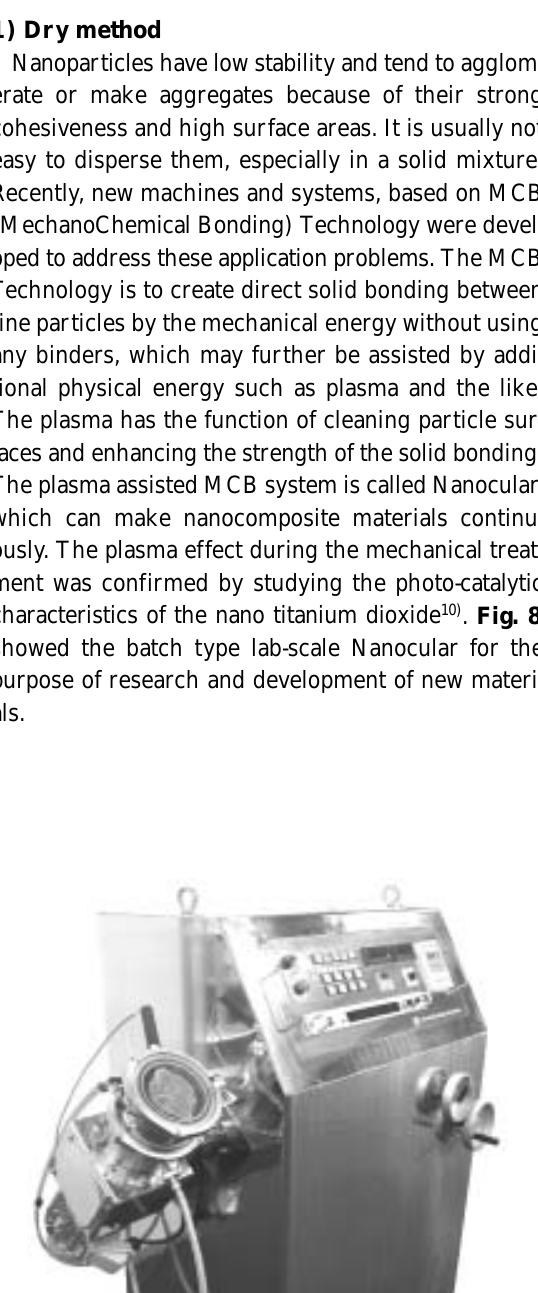
Energy consumption (cid:2) 10 6 (J/kg)